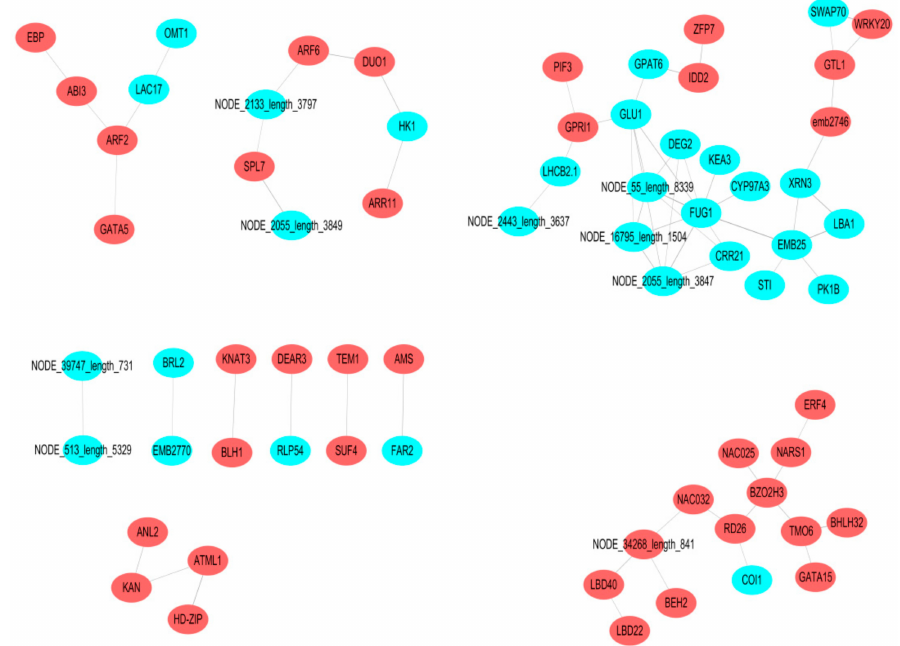
Figure 8. Prediction of protein interactions; red denotes di ff erentially expressed transcription factor genes is highly expressed in the SL, while light blue denotes transcription factors is highly expressed in the SL,. Line thickness indicates the strength of support by the data. The thicker the line, the stronger the possibility of protein